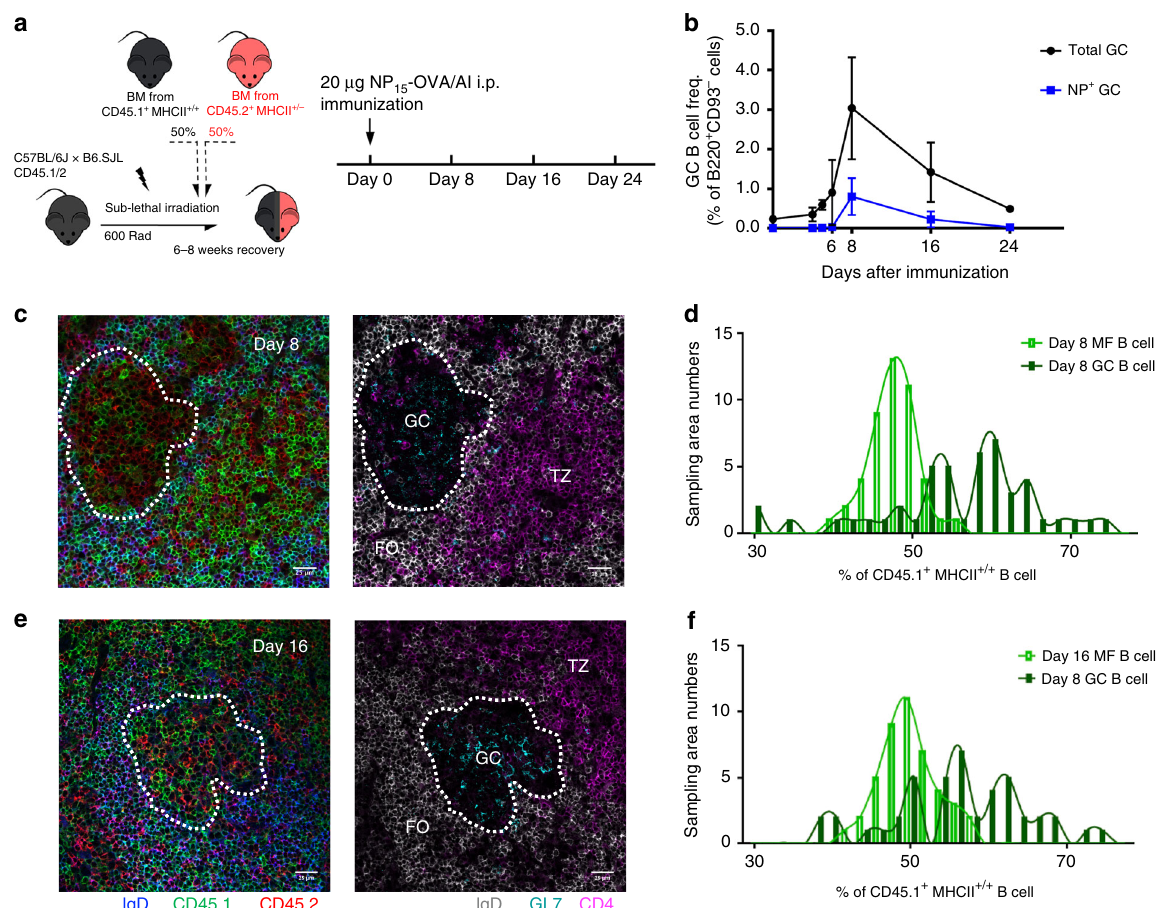
Fig. 3 MHCII + / + and MHCII + / − B cells directly compete in GCs. a Diagrammatic representation of the experimental design. Sublethally irradiated, recipient mice (CD45.1 + CD45.2 + ) were reconstituted with a 1:1 ratio of BM cells from MHCII + / + (CD45.1 + ) and MHCII + / − (CD45.2 + ) mice. Six to eight weeks after reconstitution, chimeric mice were immunized i.p. with 20 μ g NP-OVA in alum. Splenocytes were harvested, stained and examined by fl ow cytometry on days 4 – 24 post immunization. b Kinetics of GC B-cell responses are shown (total GC B cells, black circles; NP + GC B cells, blue squares; n = 3 – 13 for both strains at each time point; mean ±S.D.). c – f Frozen sections from the spleen of day 8 ( c , d ) and day 16 ( e , f ) chimeras were examined by IHC: IgD (blue and gray), CD45.1 (MHCII + / + ; green), CD45.2 (MHCII + / − ; red), GL7 (cyan), and CD4 (magenta). FO follicle, GC germinal center, TZ T-cell zone. Original magni fi cation: ×200, scale bars indicate 25 µ m. d , f Plots represent the distribution of CD45.1 + MHCII + / + B cells frequency in follicular areas (light green) or GC areas (dark green). Follicular areas (50 × 50 µ m; n = 44 – 46 from 22 – 23 follicles; 2 mice per time point) or GC areas (50 × 50 µ m; n = 44 – 46 from 22 – 23 GCs; N = 2 mice per time point) were chosen Figs. 3B and 3C). We conclude that even in direct competition, + / + + / − and MHCII B cells are comparably activated by MHCII exposure to antigen. Crucially, MHCII + / − IgD low NP + B cells labeled with the Y-Ae mAb were exactly half as bright as WT controls, demonstrating that MHCII and pMHCII are equally reduced in haploinsuf fi cient B cells (Supplementary Figs. 3D and 3E). Lower pMHCII levels on MF B cells do not impair initial activation by antigen. + / + B cells in the GC response included NP-speci fi c MHCII cells, we determined the ratios of NP-binding, CD45.1 MHCII + / + + / − and CD45.2MHCII B cells in the splenic GC compartment (Fig. 2g). This analysis con fi rmed a nearly 1:1 ratio [50.2(±4.2)% + / + + / + MHCII and 49.0(±4.0)%, respectively] of NP-reactive B1-8 and B1-8 + / + MHCII + / − MF B cells were transferred; by day 6 + / + after immunization, however, NP-binding, CD45.1 MHCII B cells constituted 74.7(±6.1)% of donor GC B cells (Fig. 2g – i). + + / + Over the course of GC response, the advantage of NP MHCII GC B cells remained relatively constant, ranging from 3:1 on day 6, to 2.5:1 on day 8, and 2:1 on day 16 (Fig. 2g – i). Furthermore,